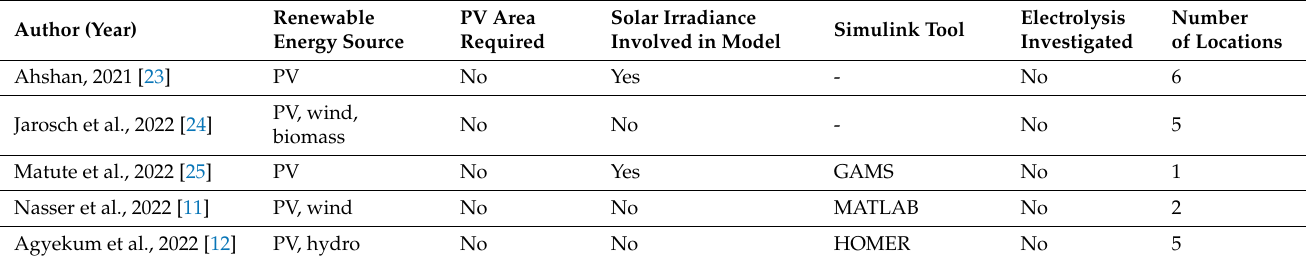
Table 1. Summary of some investigated factors in the literature.